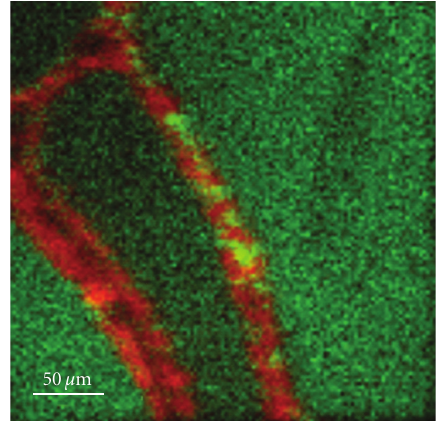
Figure 2: TOF-SIMS image of a second tissue section from the PTU pretreated patient. The green in the TOF-SIMS image represents the signal from iodine and the red marks PO − membranes). Iodine signals were located within the follicle lumina, but also within